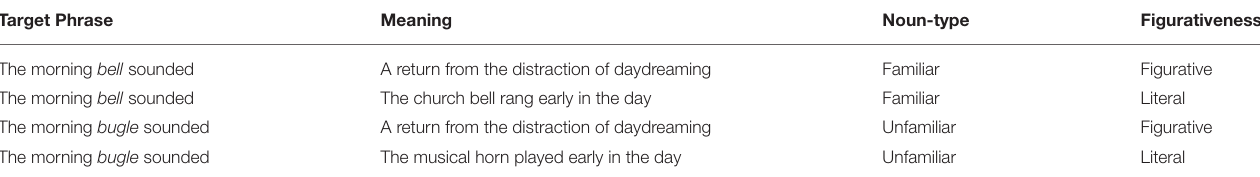
TABLE 1 | Example Phrase